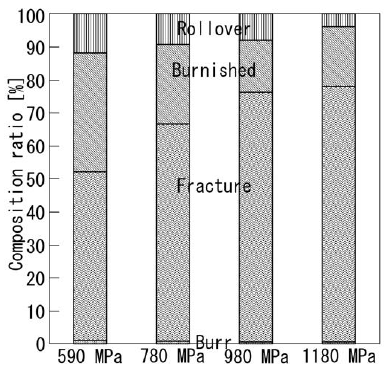
Figure 3. Sheared edge: ( a ) 590 MPa steel sheet; ( b ) 780 MPa steel sheet; ( c ) 980 MPa steel sheet; and ( d ) 1180 MPa steel sheet.